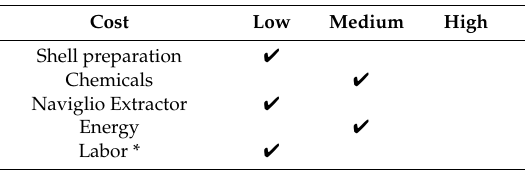
Table 3. Overview of cost for the rapid solid liquid dynamic extraction (RSLDE) application to the shells of sea